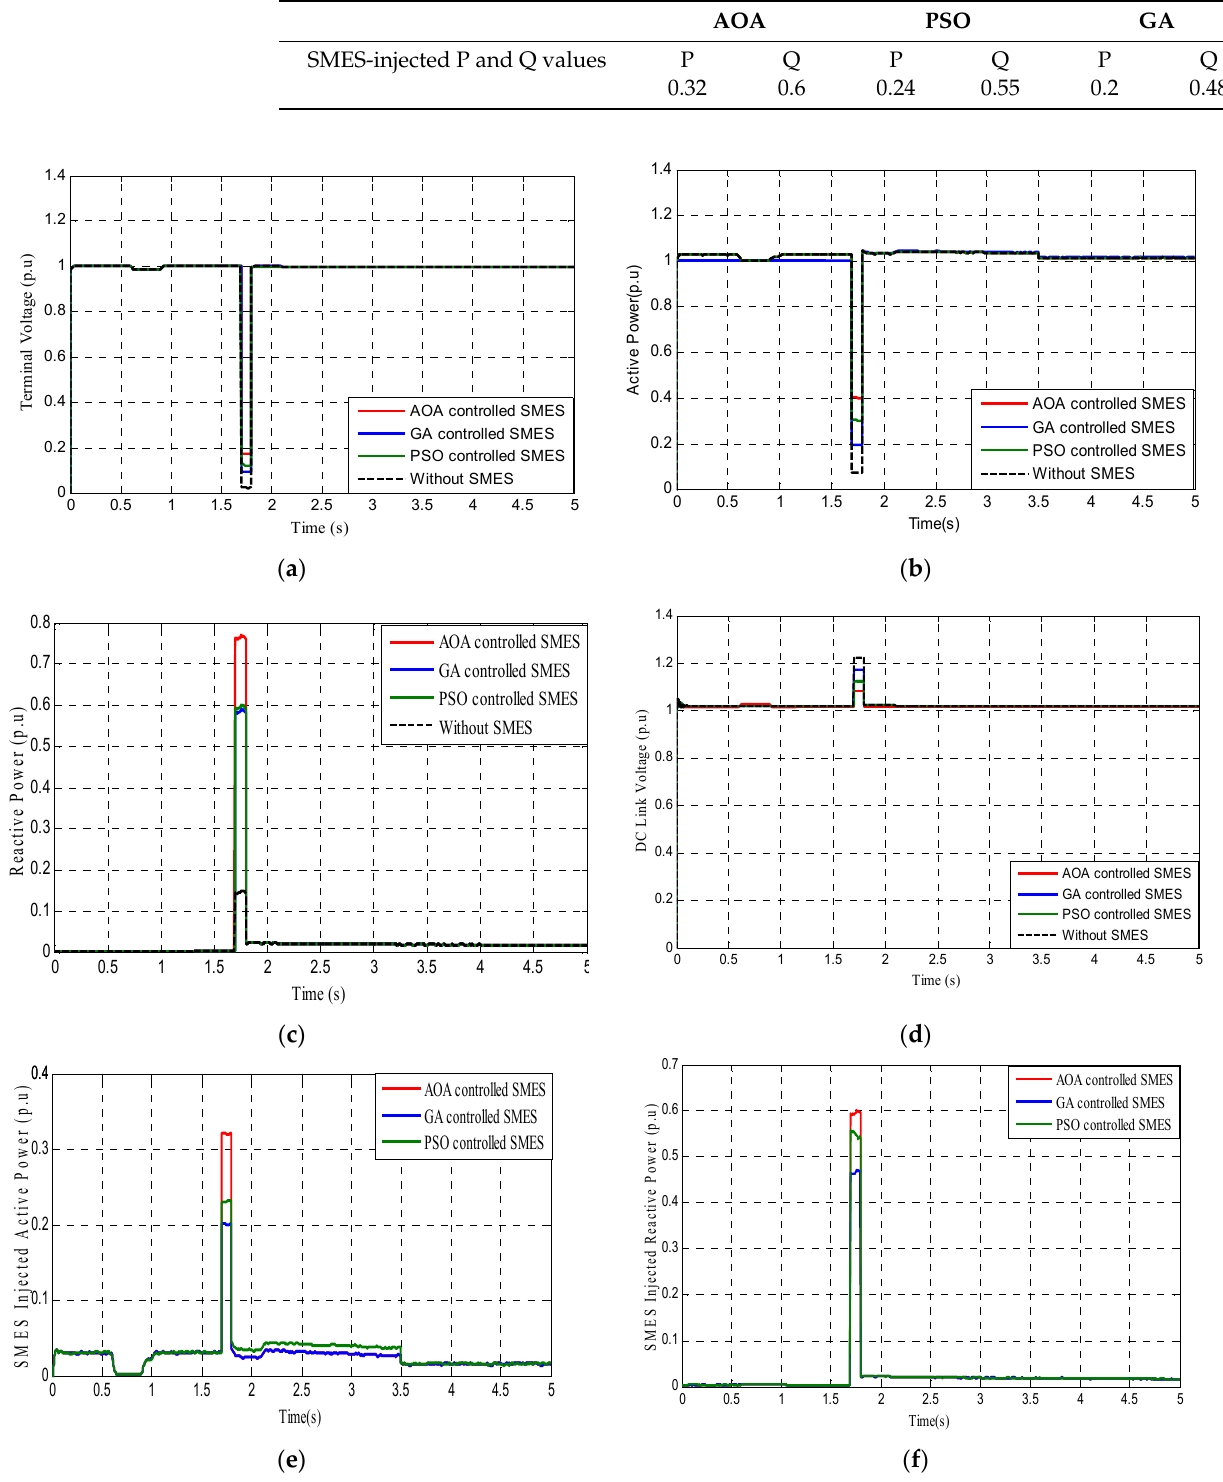
Figure 11. Simulation curves for L-L-L-G fault using the AOA, the GA, and PSO: ( a ) terminal voltage; ( b ) P curve; ( c ) Q curve; ( d ) DC link voltage curve; ( e ) SMES-injected active power; ( f ) SMES injected reactive power.